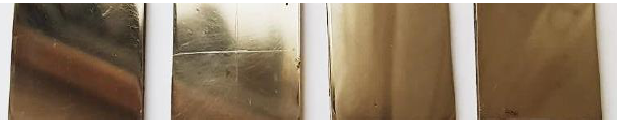
Figure 7: Hardness test samples